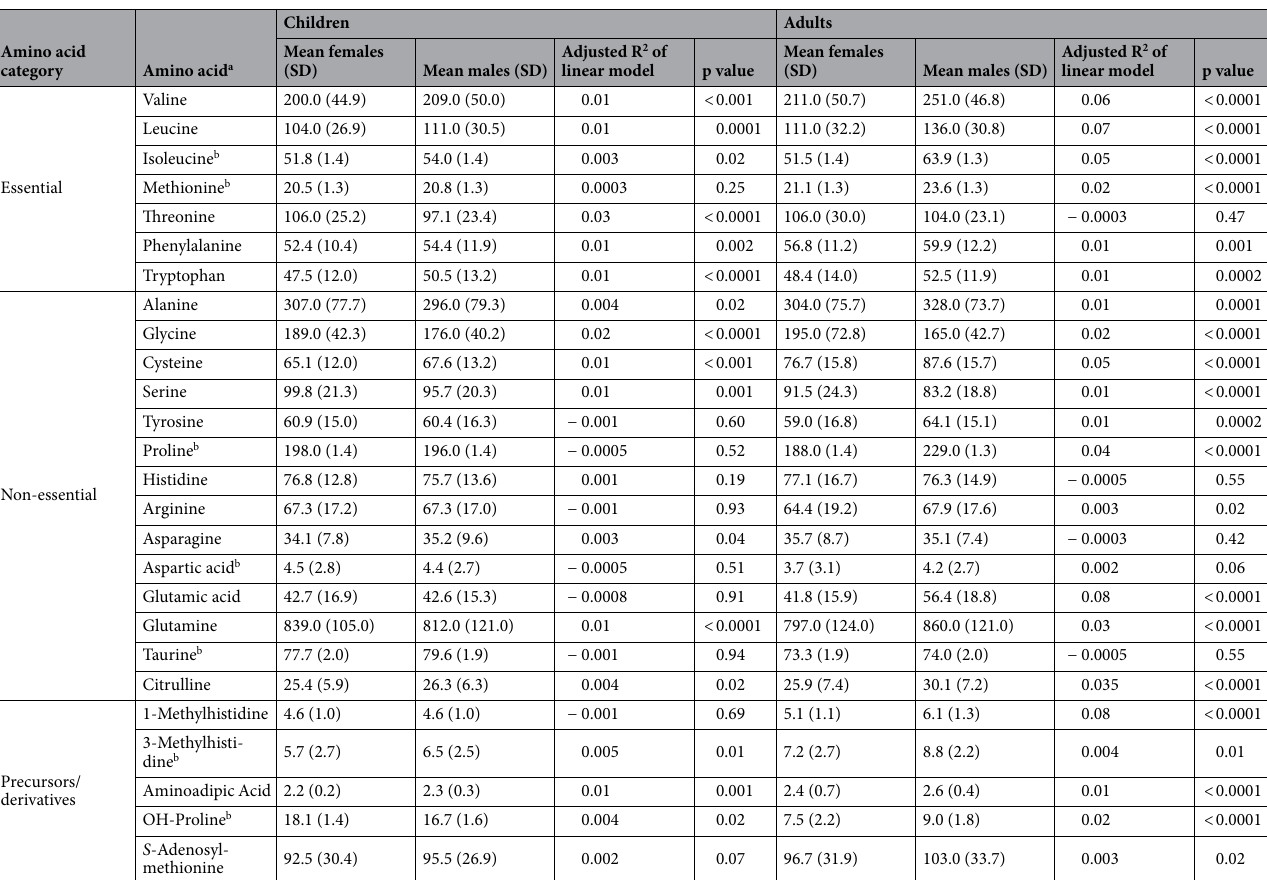
Table 4. Means, standard deviations, and linear model results by sex and generation. a All in µM except for S -Adenosylmethionine in nM. b Log transformed variables with back-transformed means and standard